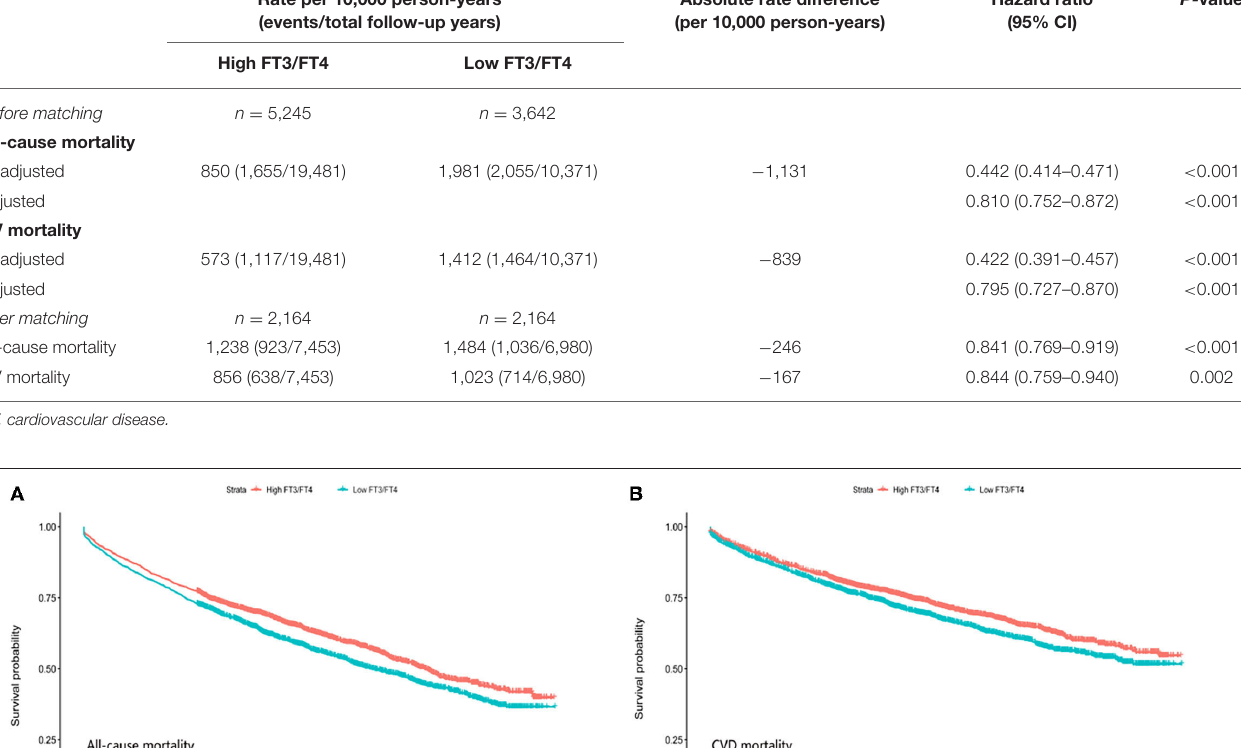
TABLE 2 | Hazard ratio for FT3/FT4 ratio and all-cause/CV mortality. Rate per 10,000 person-years (events/total follow-up years)